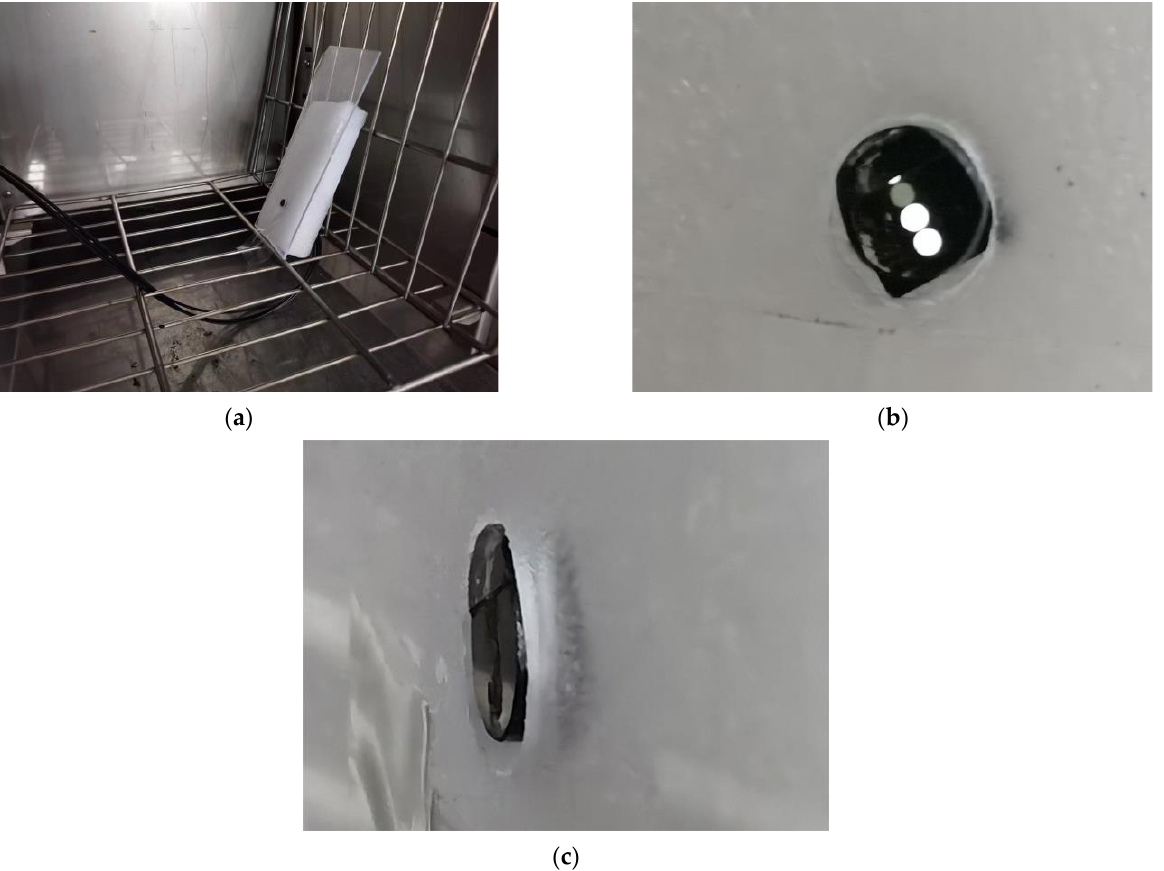
Figure 7. Low-temperature icing test: ( a ) fiber-optic ice sensor installation; ( b ) front view of fiber-optic ice sensor probe; ( c ) side view of fiber-optic ice sensor probe.